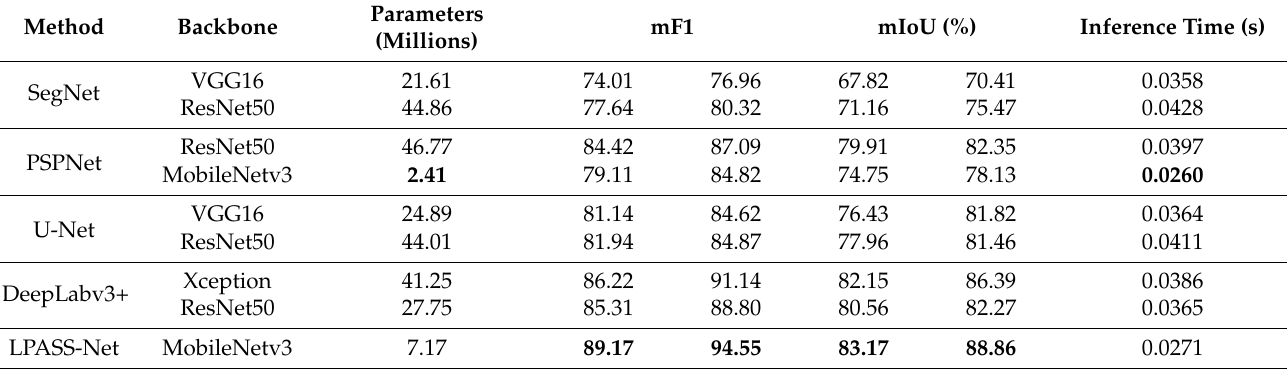
Table 5. Comparison of quantitative experimental results on the two datasets, where bold numbers indicate the best value for each column. The first of these numbers is the result from the BDCI 2017 dataset, the second is from the ISPRS Potsdam dataset, and the inferred time is the time required to predict a 256 × 256 patch image.